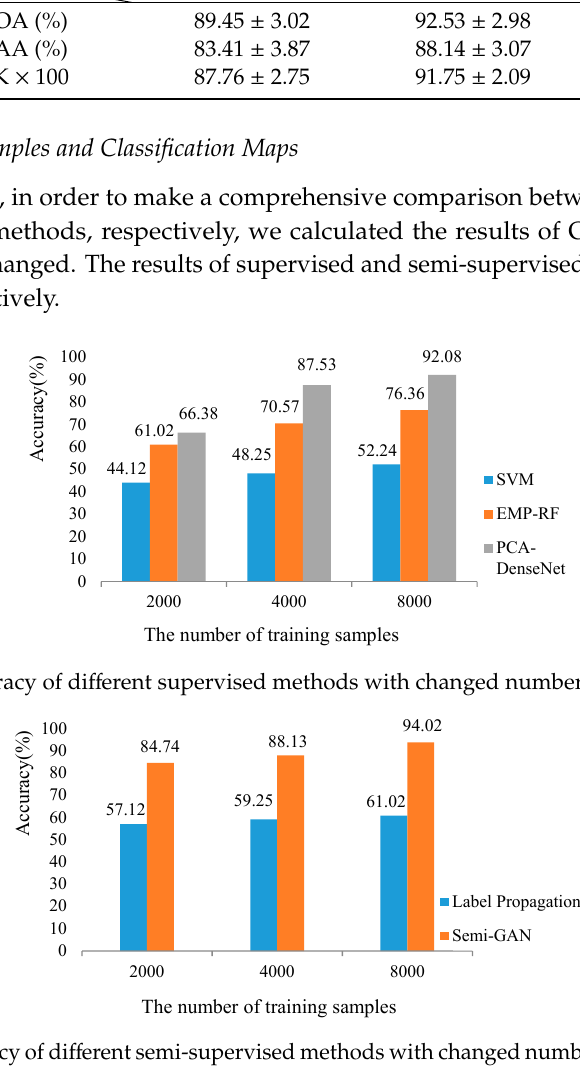
( e ) Figure 8. ( a ) False-color composite image of Indian Pines dataset; The classification maps using ( b ) EMP-RF; ( c ) PCA-DenseNet; ( d ) DenseNet-CRF; ( e ) Semi-GAN.